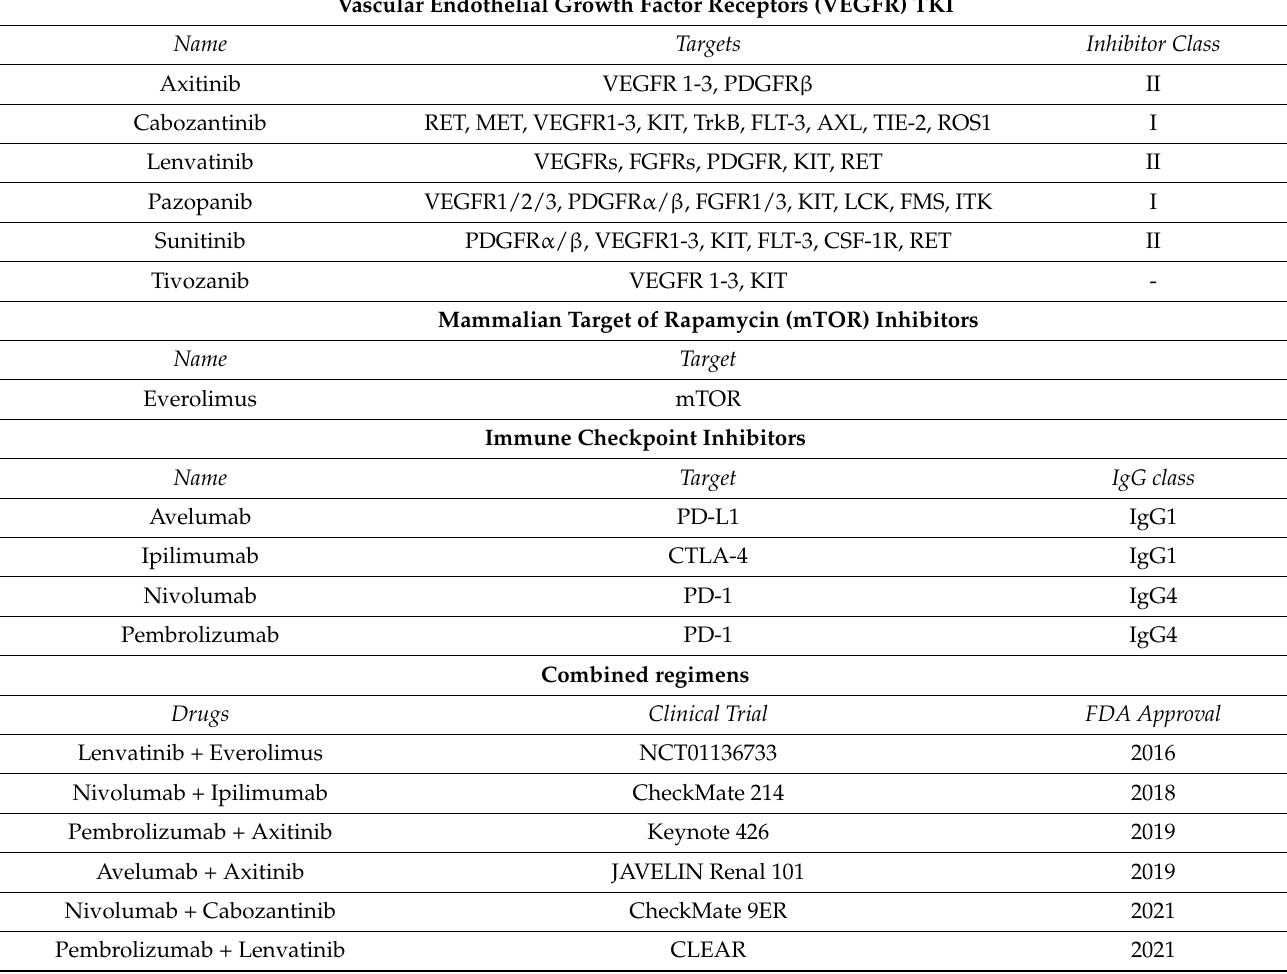
Table 1. List of the main anticancer agents available for RCC treatment as monotherapy and/or combined